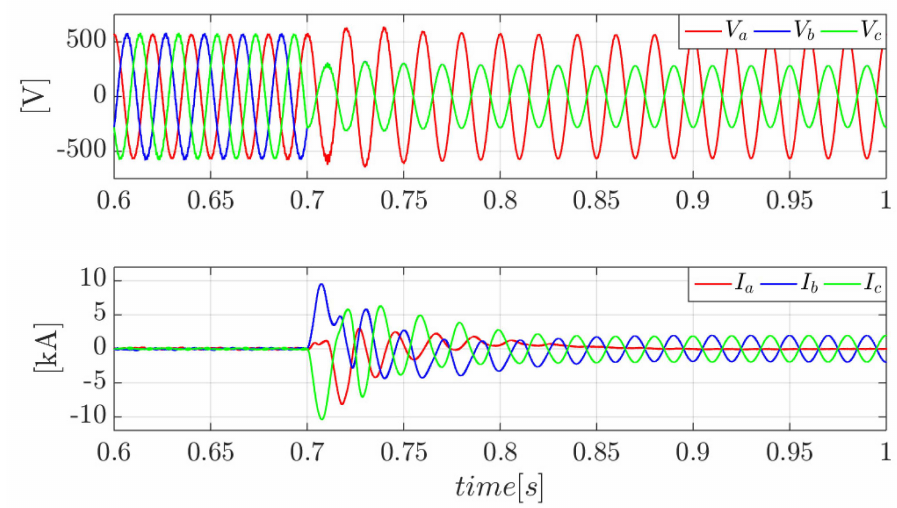
Figure 22. GFM converter instantaneous voltage and currents during an unbalanced fault with 0.5 p.u. depth.